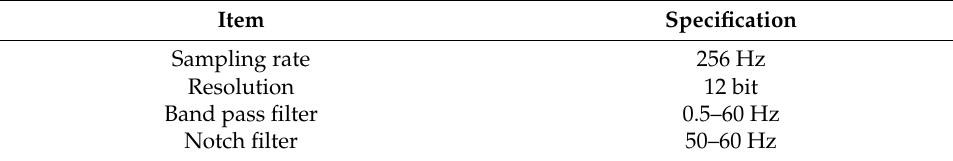
Table 6. Specifications of the thermal-imaging camera.